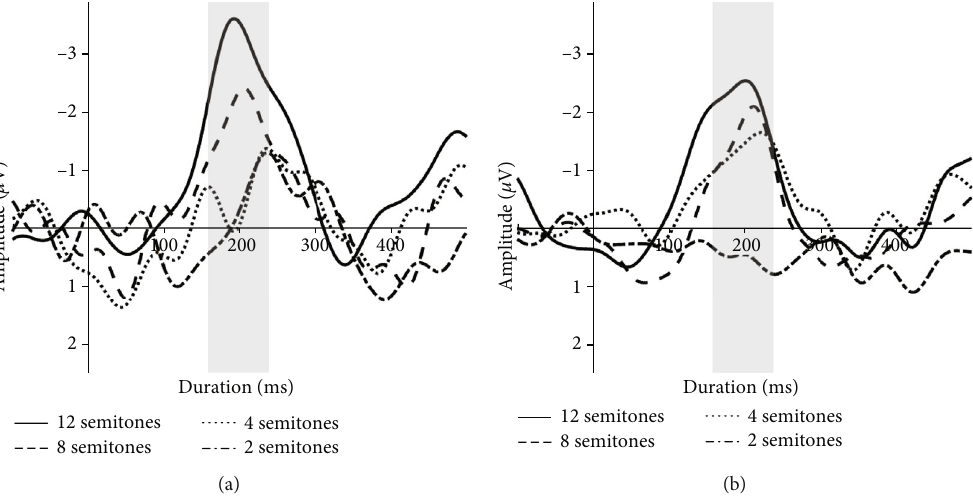
Figure 3: Grand-average MMN waveforms for distinct pitch di ff erences for CI users with good (a) and poor (b) performance at electrode Fz. Gray shading indicates the time window used to calculate amplitudes and latencies (156 – 236 ms). Table 4: MMN amplitude and latency ( mean ± standarddeviation ) according to pitch change in CI users with good and poor performance. Pitch changes Amplitude ( μ V) Latency (ms) Cochlear implants (good